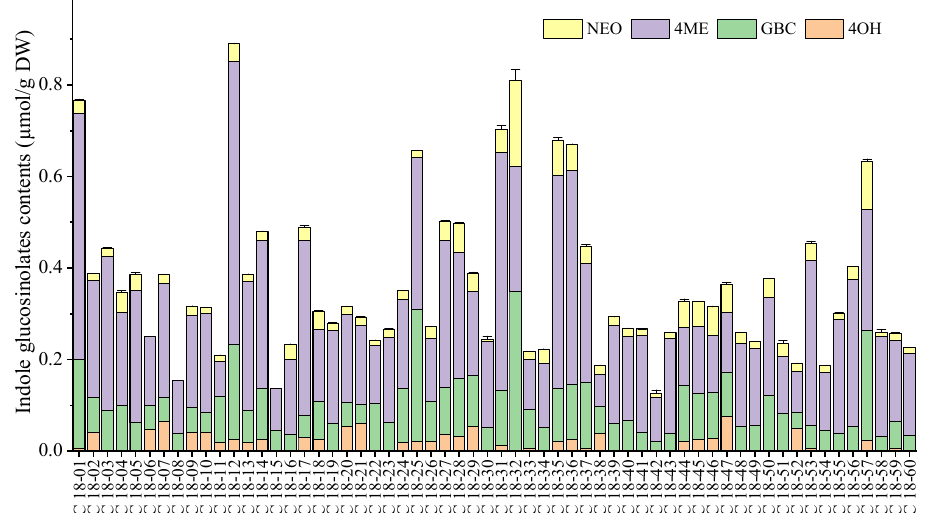
Figure 4. Variation of indole glucosinolate contents in different mustard resources’ leaves. The indole glucosinolates are 4-Hydroxyglucobrassicin (4OH), glucobrassicin (GBC), 4-Methoxyglucobrassicin (4ME), neoglucobrassicin (NEO), respectively.